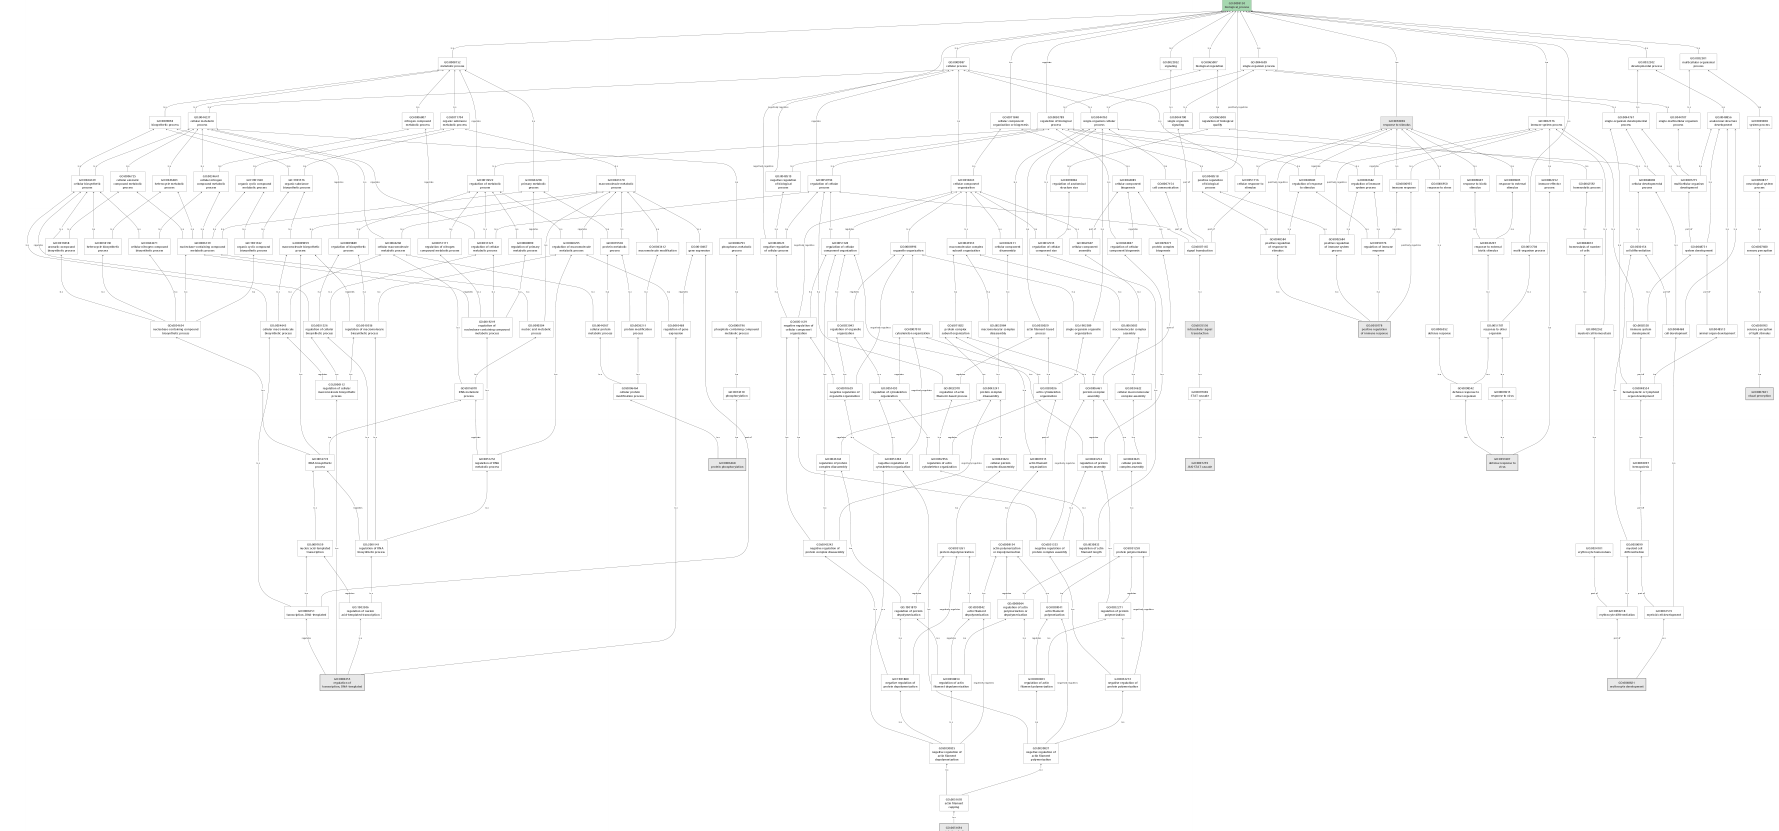
Figure 1. Gene ontology of biology processes for growth traits in